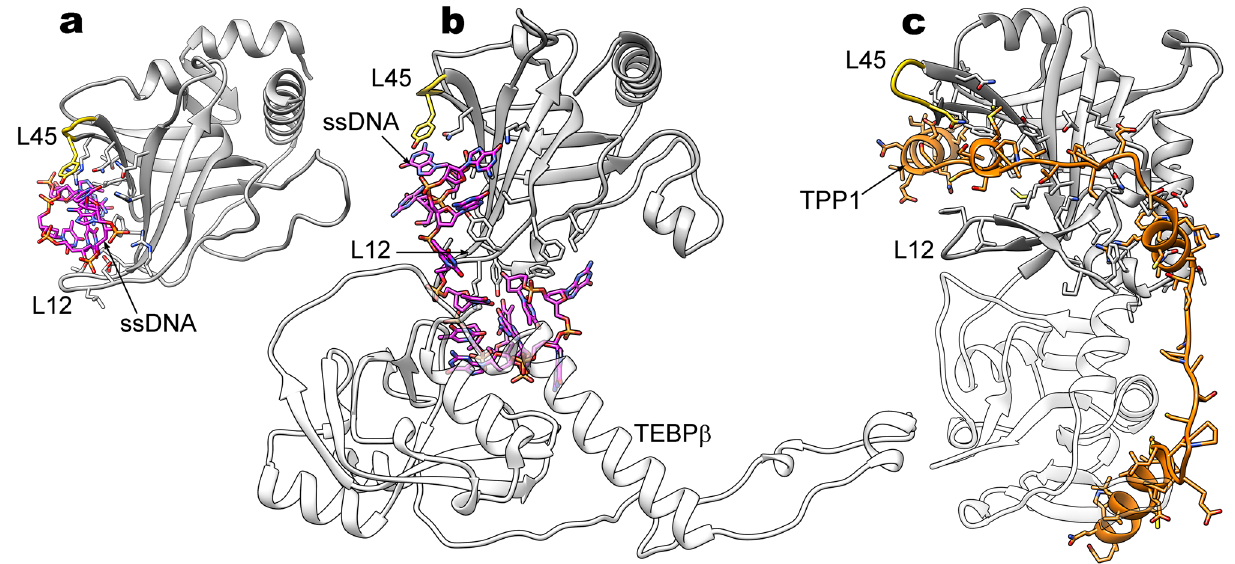
Figure 8. Binding interfaces of the telomeric OB fold proteins: ( a ) S. pombe POT1 with single-stranded telomeric DNA fragment (magenta); ( b ) N-terminal OB fold domain of S.nova TEBPα complexed with TEBPβ and a fragment of ssDNA (magenta); ( c ) human POT1 complexed with a peptide fragment of TPP1 (orange). The loop 45 is shown in gold. Side chains of the ligand-interacting residues of OB fold proteins are shown in sticks. Figure was made using UCSF Chimera v. 1.12 (https ://www.cgl.ucsf.edu/chime